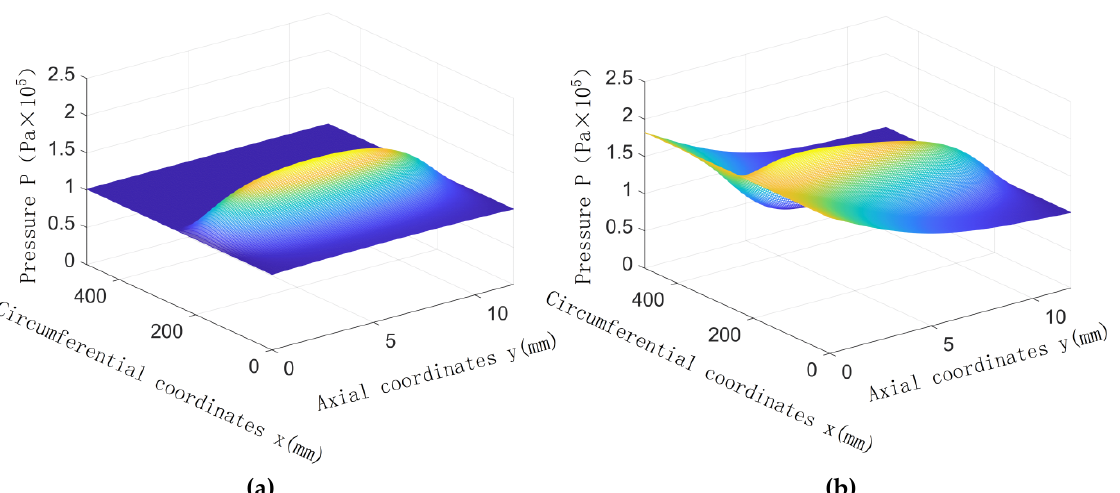
Figure 8. Mode 4 (only the inner rotor rotates): ( a ) without inlet pressure difference; ( b ) with inlet pressure difference.